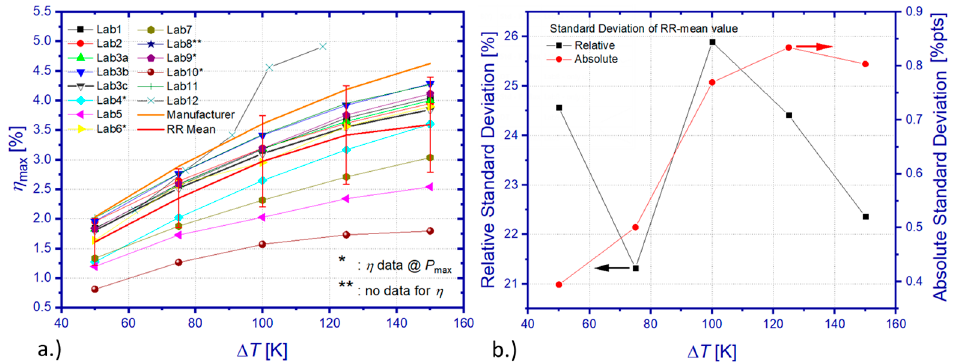
Figure 12. RR results for the maximum efficiency η max in dependence on the temperature difference Δ T ( a ). The mean value (RR mean) and the standard deviation (shown by error bars for the RR mean) have been calculated from all available data sets. For comparison, manufacturer specifications are plotted. The absolute and relative standard deviations are shown in ( b ).